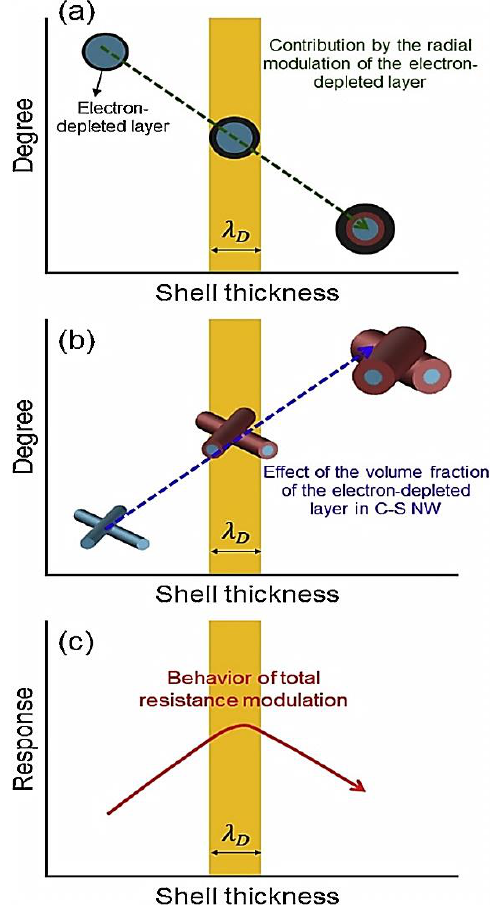
Figure 1. Effect of various mechanisms on the ZnO-SnO 2 C–S NW sensor response: ( a ) radial modulation effect, ( b ) volume fraction effect, and ( c ) response variation as a function of shell thickness. Reproduced from [71] with the permission of